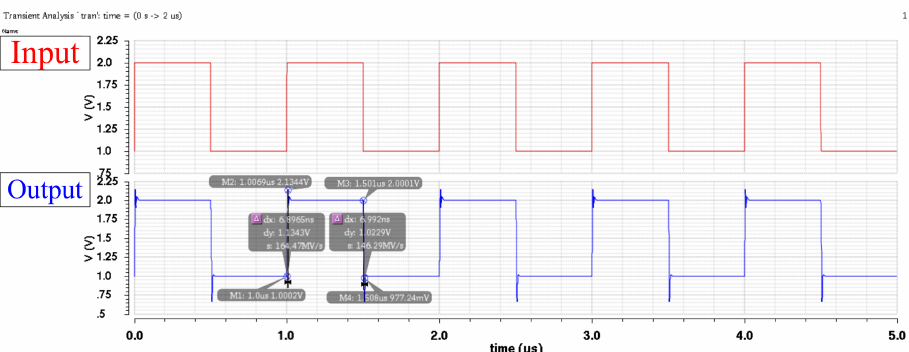
Figure 12. The transient simulation results of slew rate when the proposed circuit in closed-loop state is fed with a small-swing